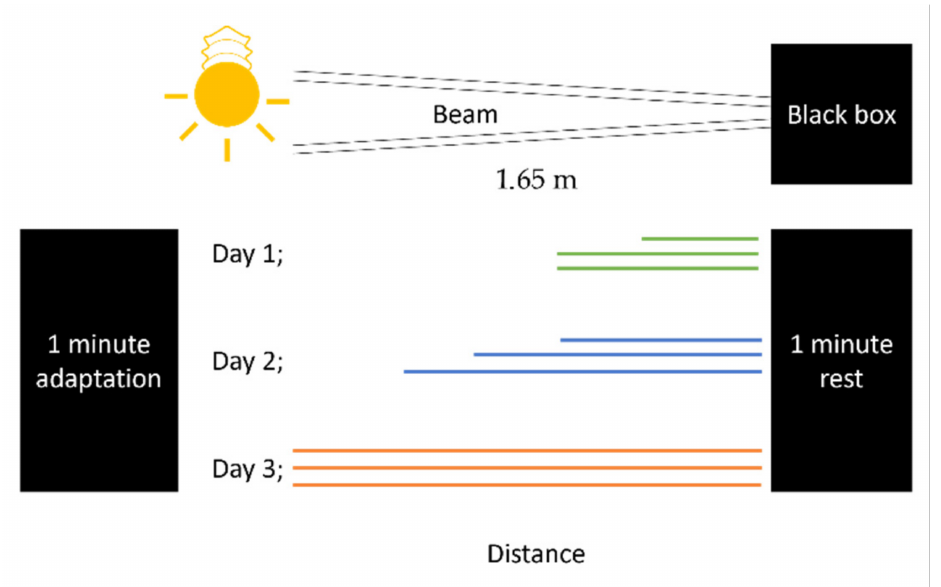
Figure 8. Beam walking test. Animals were trained three times per day during 3 days before MCAO and on days 12–14 after MCAO. First, animals are placed in the black box with a nesting material from the cage for 1 min to make them comfortable during the test. Then, animals are placed in different distances from the black box and are trained to reach the black box. Once they succeed, they rest for 1 min in the box. On day 14 after MCAO, the test with whole distance is repeated, and the number of steps, errors, and slides are counted. Each line represents one attempt. Colors correspond to different days of